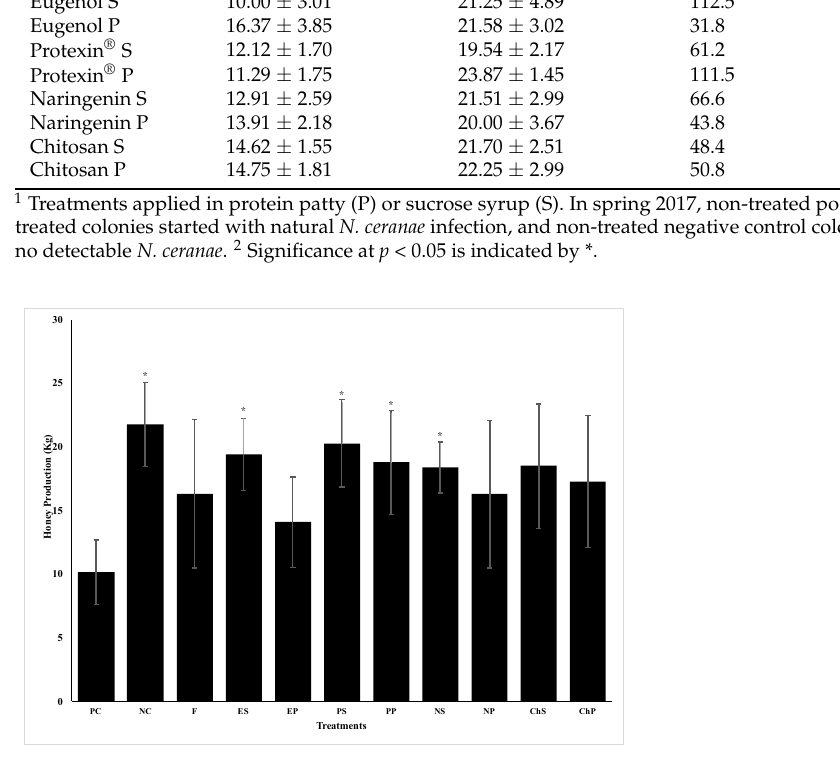
Figure 1. Effect of spring 2017 treatments on honey production per colony (Kg ± SE) three months post-treatment for positive control (PC), negative control (NC), fumagillin (F) applied in syrup, eugenol in syrup (ES), eugenol in patty (EP), Protexin ® in syrup (PS), Protexin ® in patty (PP), naringenin in syrup (NS), naringenin in patty (NP), chitosan in syrup (ChS) and chitosan in patty (ChP). Means are from six colonies per treatment. * indicate significant differences ( p < 0.05) relative to the PC based on t tests. Bees of positive and negative control colonies both showed infection at the time of